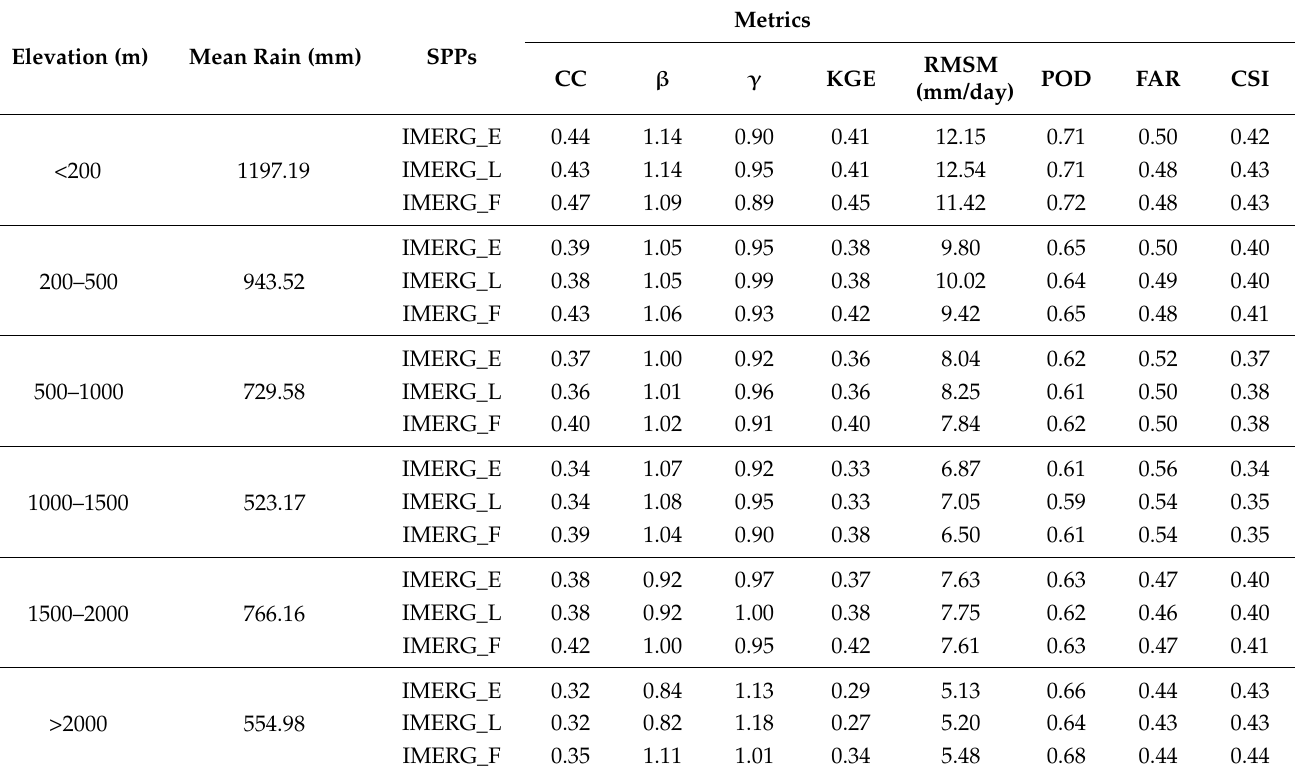
Table 4. Performance metrics associated with IMERG products in 6 classes of